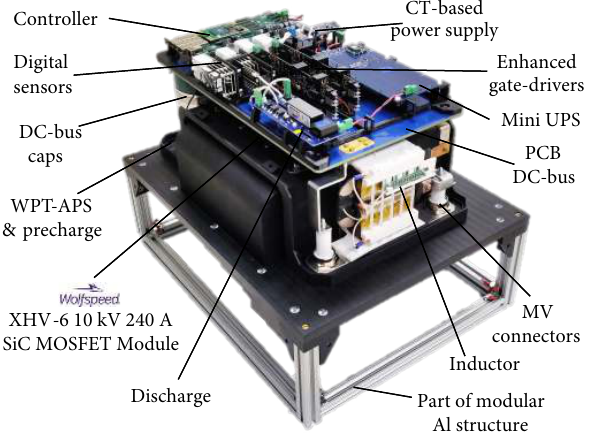
Fig. 13 10 kV SiC MOSFET-based power-cell with indicated constitutive parts outside enclosure.